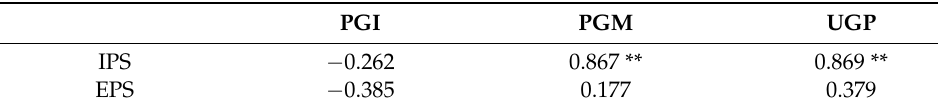
Table 1. Correlation coefficients between the intracellular polysaccharide (IPS) and exopolysaccharide (EPS) contents and phosphoglucose isomerase (PGI), phosphoglucomutase (PGM), and UDPG- pyrophosphorylase (UGP) activities.